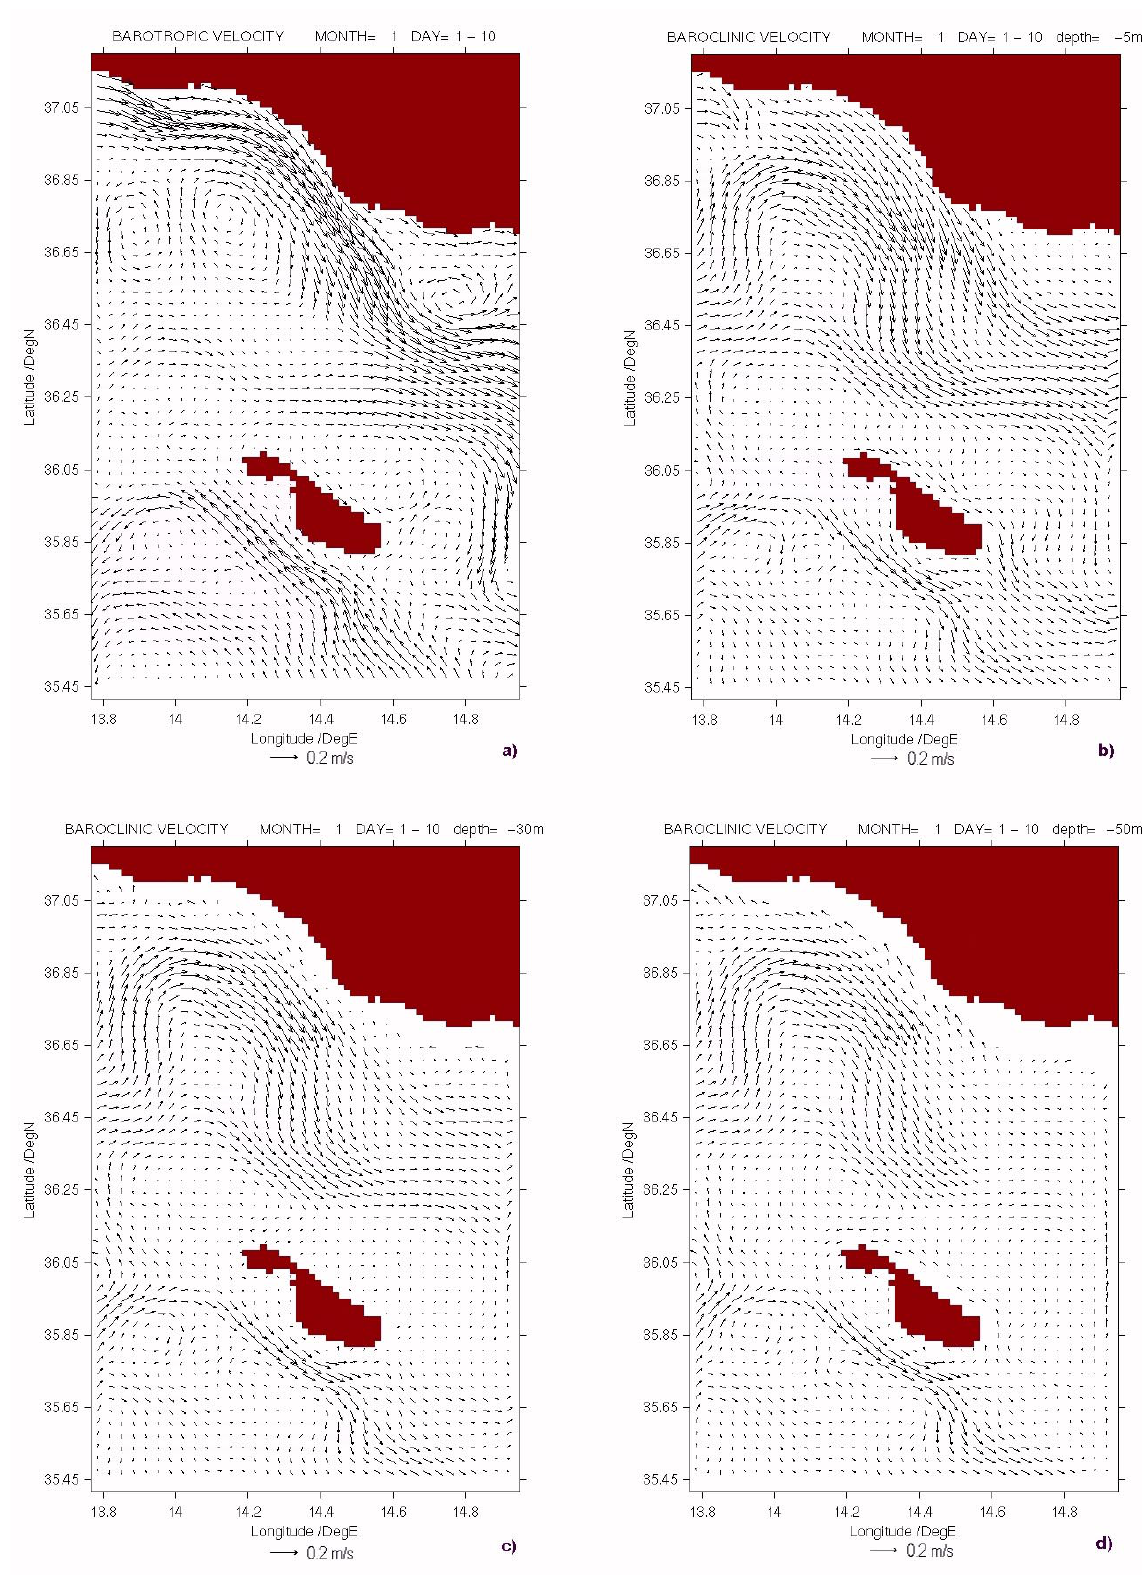
Fig. 15. Horizontal fields of (a) barotropic velocity, and baroclinic velocity at (b) 5m, (c) 30m and (d) 50m depth, for the first ten days of January. Plotting is done only at every odd grid